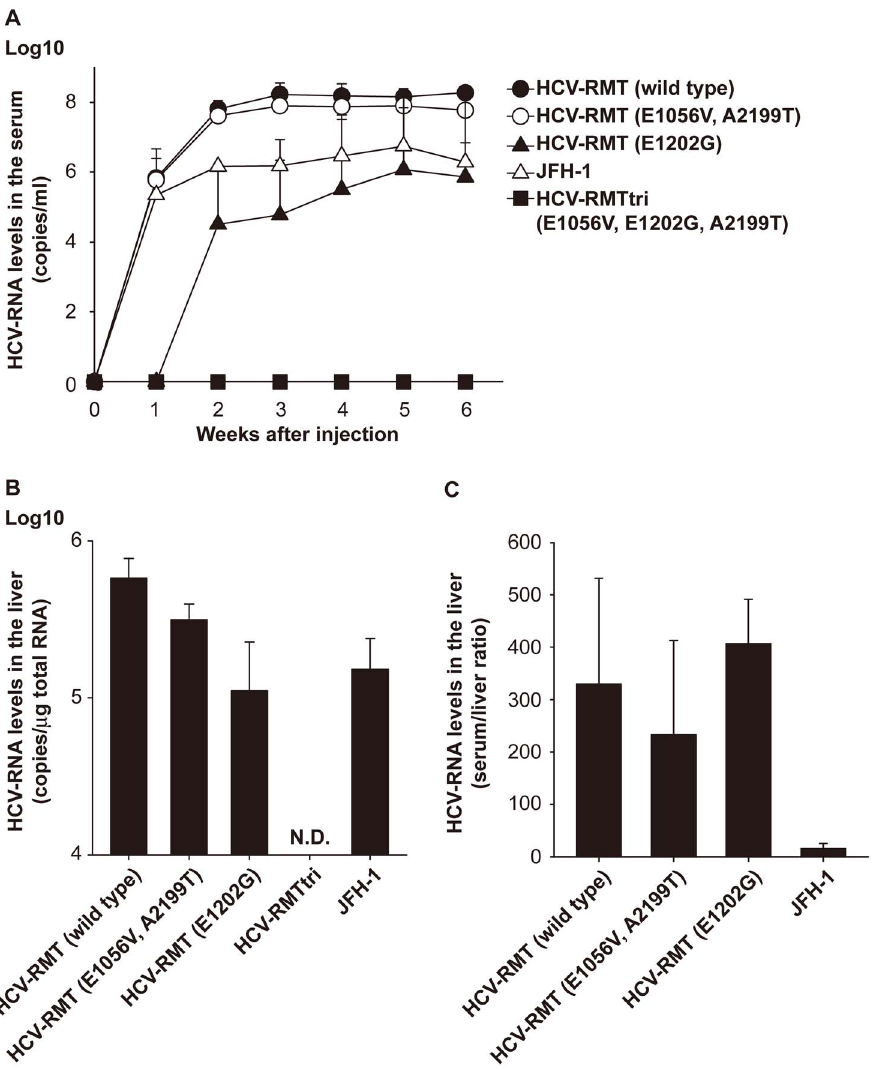
Figure 4. Invivo replication ability of HCV-RMT derivatives. (A) Change in HCV copy numbers in the serum of chimeric mice in which the HCV genome was directly injected into the livers. HCV-RMT (wild type): closed circles, HCV-RMT (E1056V and A2199T): open circles, HCV-RMT (E1202G): closed triangles, HCV-RMTtri: closed squares, JFH-1: open triangles. Data are indicated as the mean 6 S.D. (B) HCV copy number in the livers. N.D.: not detected. (C) Serum/liver ratio of HCV copy number. Table 1. Relationship between the in vitro and in vivo replication ability of HCV-RMT derivatives.